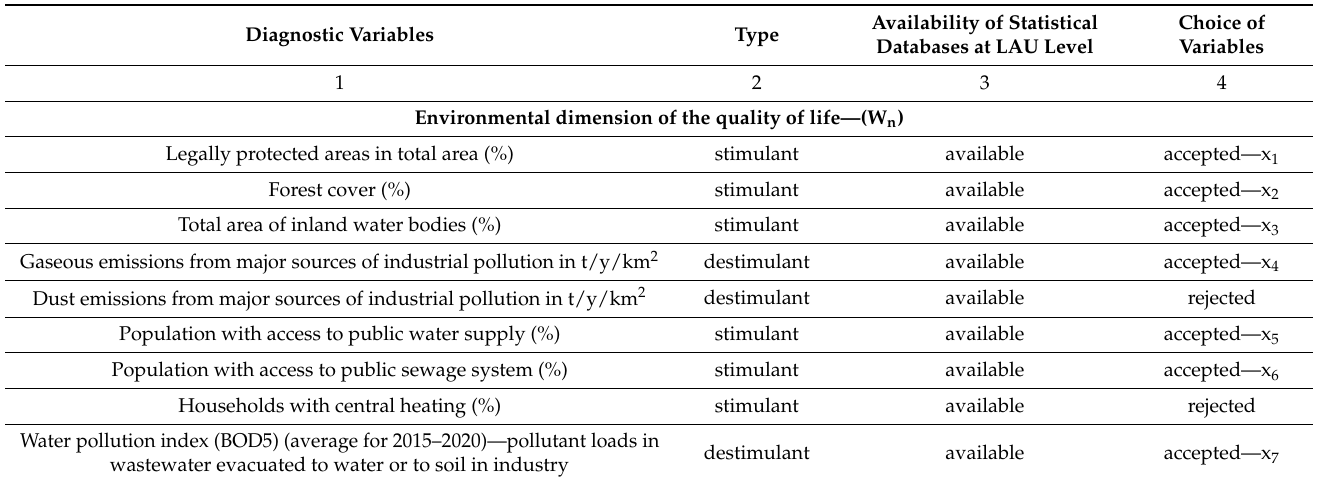
Table 2. Diagnostic variables for evaluating the implementation of green economy